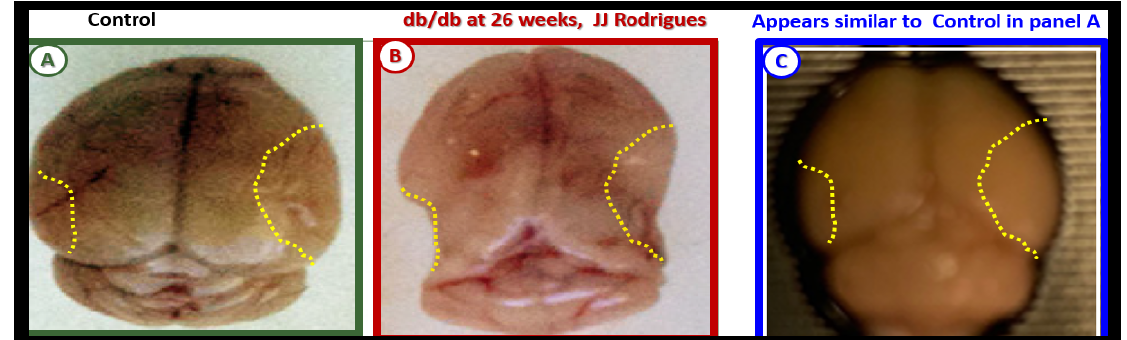
Figure 12. Gross brain atrophy in the db/db model but not in the diabetic BTBR ob/ob model. Panel B illustrates the brain atrophy at the time of surgical removal of the diabetic db/db models as compared to control models in Panel A . Panel B depicts the marked atrophy or loss in the cortical-parietal-hippocampal regions (outlined by the yellow dashed lines) in comparison to the control in Panel A at 26-weeks. Panel C demonstrates the BTBR ob/ob model at 20-weeks without atrophy in the parietal-hippocampal regions of the whole brain when compared to the db/db model in Panel B at 26-weeks. This may correlate with the less severe ultrastructural remodeling of the neurovascular unit and less microglial neuroinflammation in BTBR ob/ob mice as compared to db/db mice. Panels A and B CC by NC-ND [75].